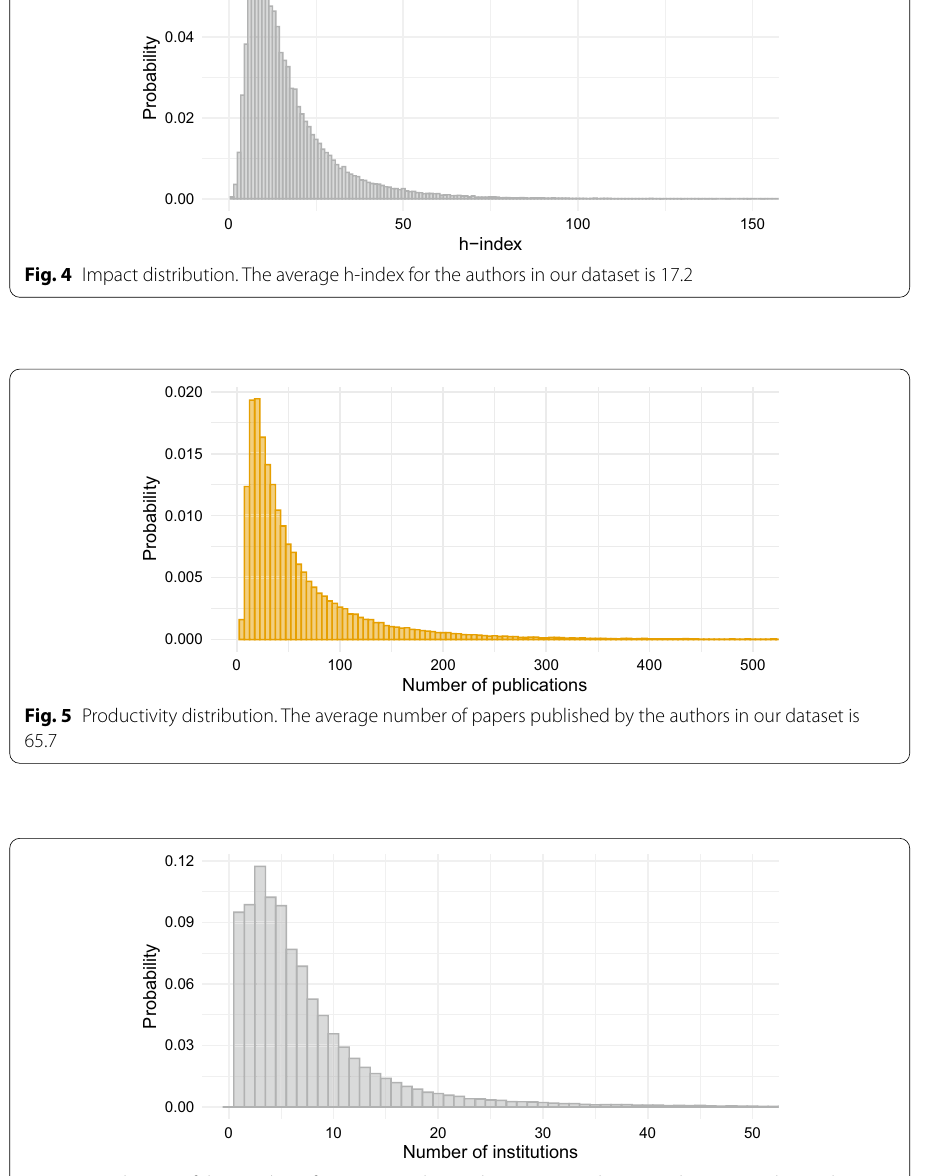
Fig. 6 Distribution of the number of institutions changed. On average, the researchers in our dataset have changed affiliation 7.8